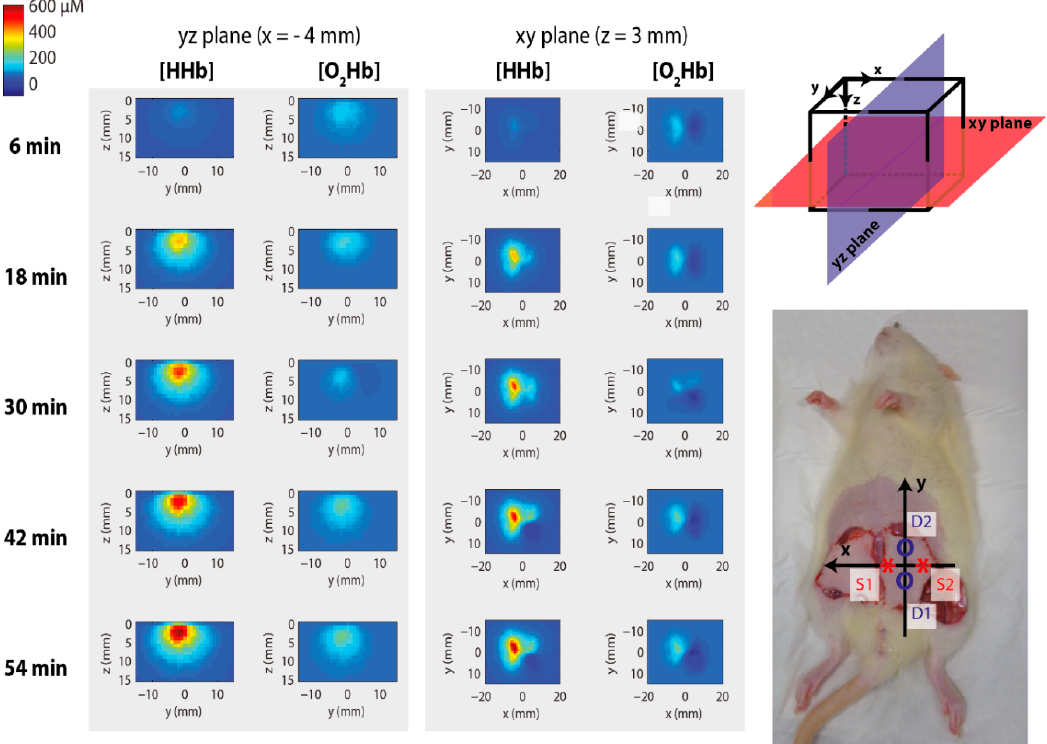
Figure 15. On the ( left ), maps of recovered oxy- and deoxy-hemoglobin. On the ( right ), volume used for reconstruction (top) and the mouse after the flap surgery with indication of source (S) and detector (D) fibers position. Figure modified from